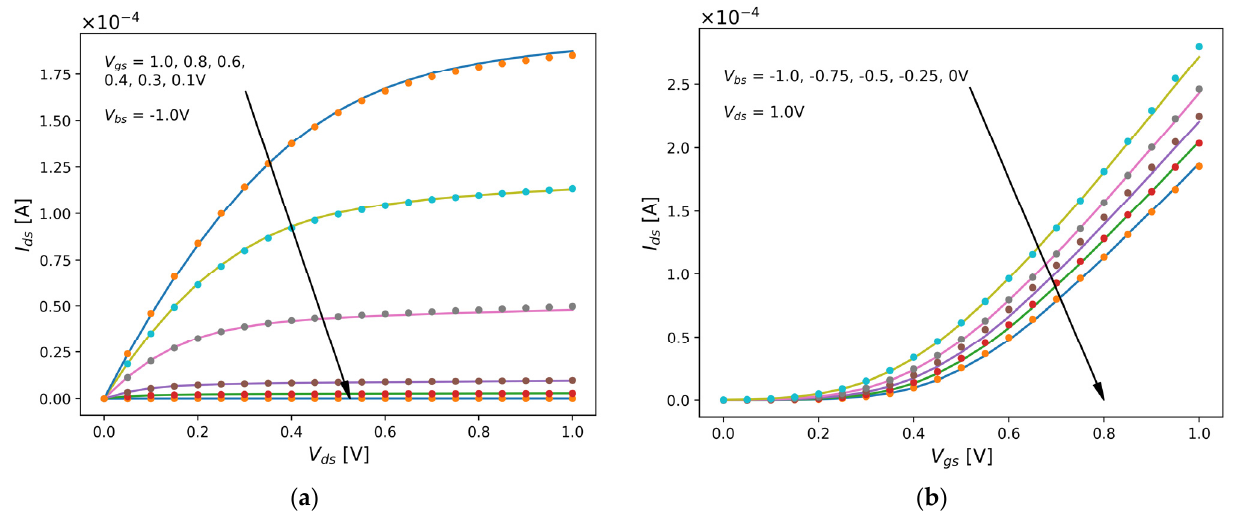
Figure 13. IV fitting curves of the first set of measured data: ( a ) I ds –V ds curves with T = 0 °C, W = 654 nm, L = 200 nm; ( b ) I ds –V gs curves with T = 0 °C, W = 654 nm, L = 200 nm.